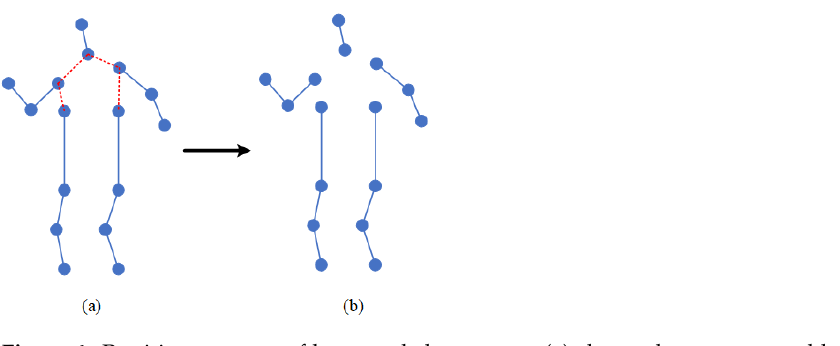
Figure 4. Partition strategy of human skeleton map. ( a ) shows the unprocessed human skeleton diagram, in which the red connecting part represents the divided connecting line, and ( b ) shows the human skeleton diagram after being divided into five